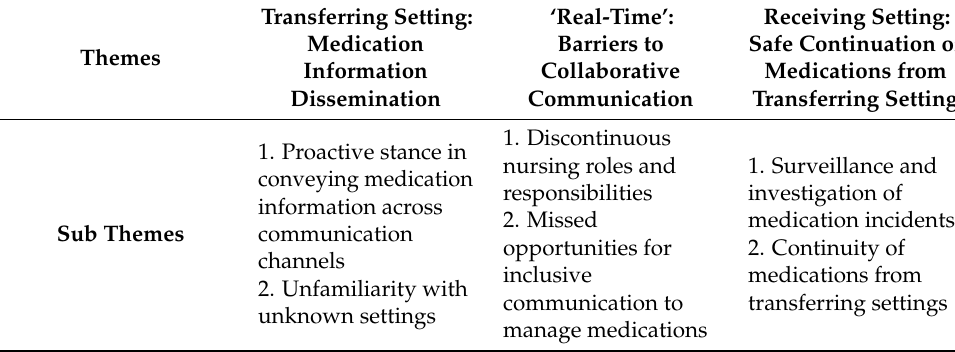
Table 2. Summary of themes and